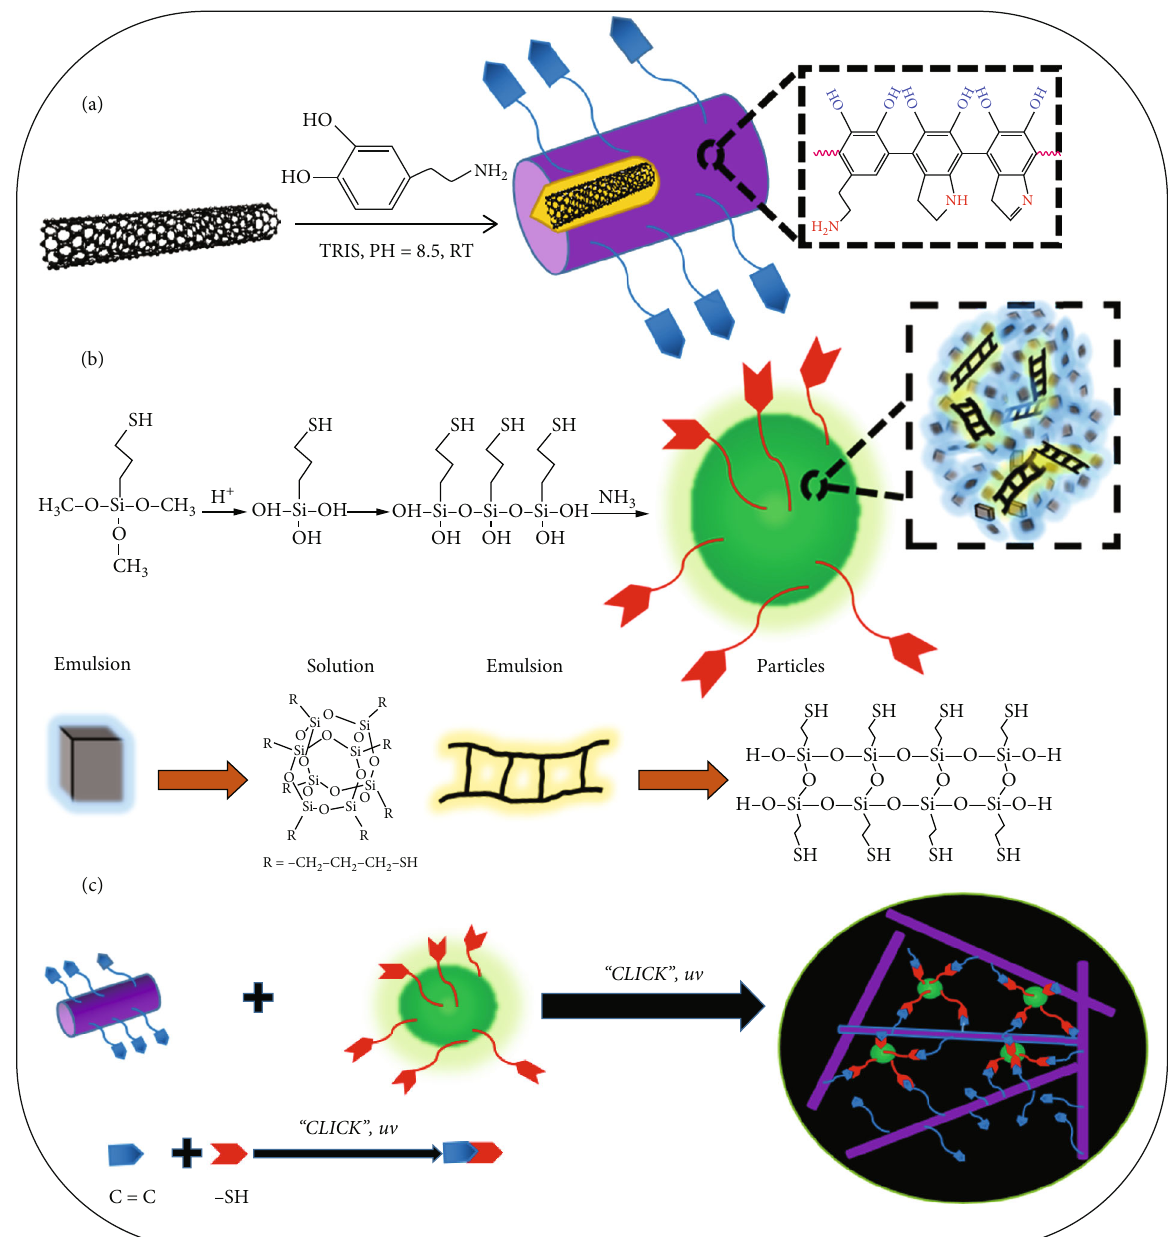
Figure 1: Schematic representation of the synthetic route from CNTs to CNTs-PDA and